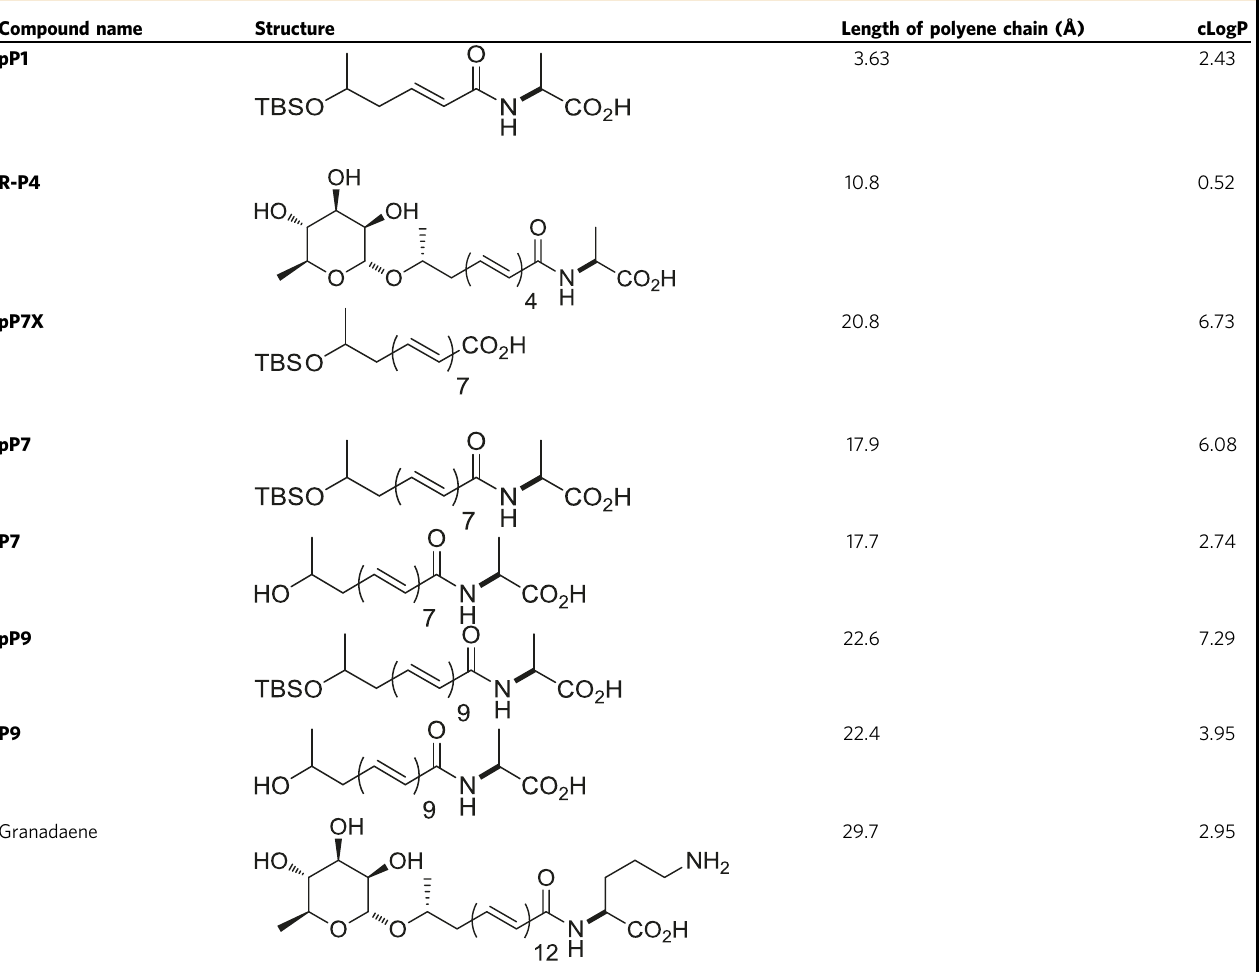
Table 1 The chemical structures and estimated polyene chain lengths and calculated logarithm of its partition coef fi cient between n -octanol and water (cLogP) of synthetic analogs and